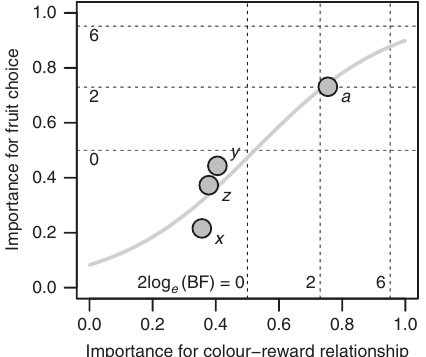
Fig. 3 Frugivorous birds use the most reliable component of fruit colouration to discriminate the nutrient content of fruit pulp. The marginal selection probability of the chromatic colour components ( x , y , z ) and the brightness of fruits ( a ) in the avian colour space (see Methods) from the Bayesian model relating fruit colour to the content of nutrients (Table 1) plotted against the marginal selection probability of each colour component from the Bayesian structural equation model relating frugivore traits to the colour pro fi les of consumed fruits (Table 2). The line represents the fi t of a logistic regression model ( y = − 2.4 + 4.6 x ; z = 51.8; n = 6000 MCMC samples; P < 0.001). Dotted lines indicate 2log e (Bayes factor) (BF).